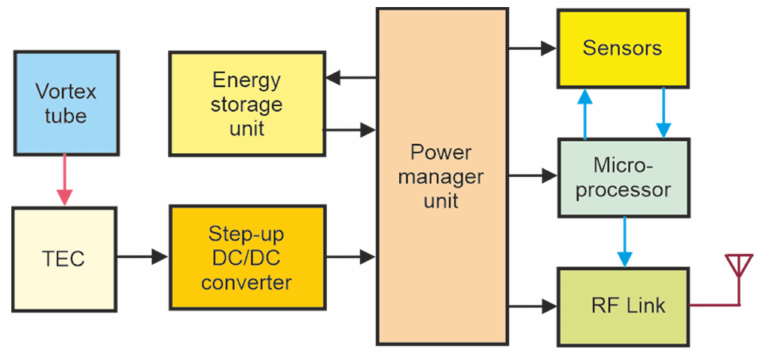
Figure 10. Block diagram of the WSN power supply